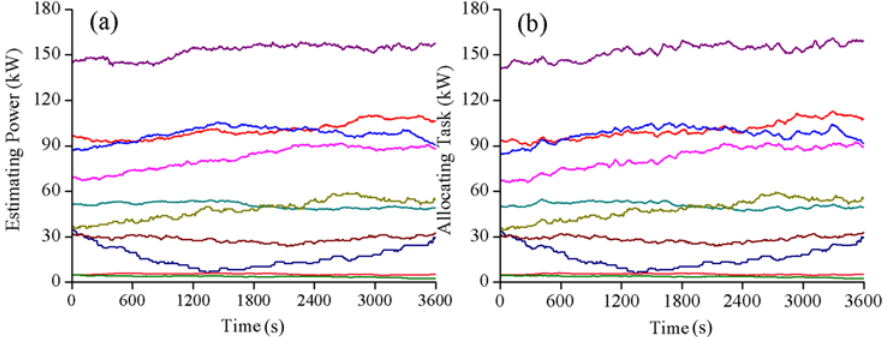
Figure 5. ( a ) The estimated power trajectory of AC groups; ( b ) assigned task of selected AC groups.